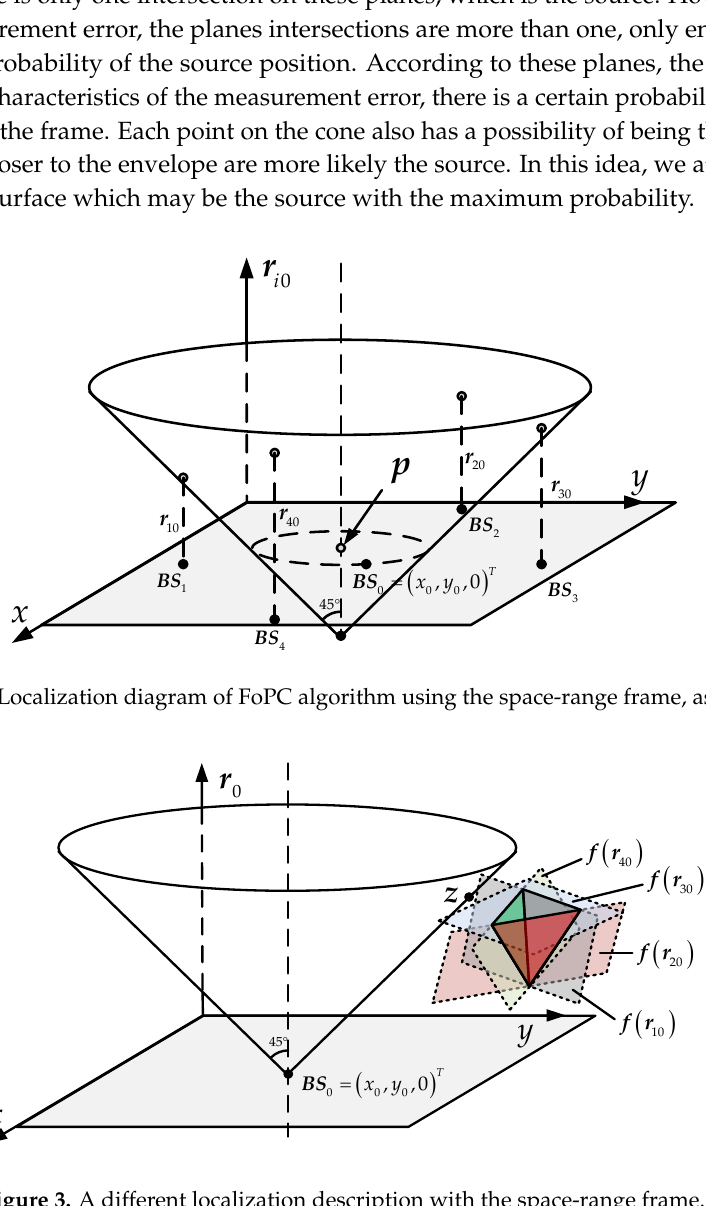
Figure 3. A different localization description with the space-range frame.